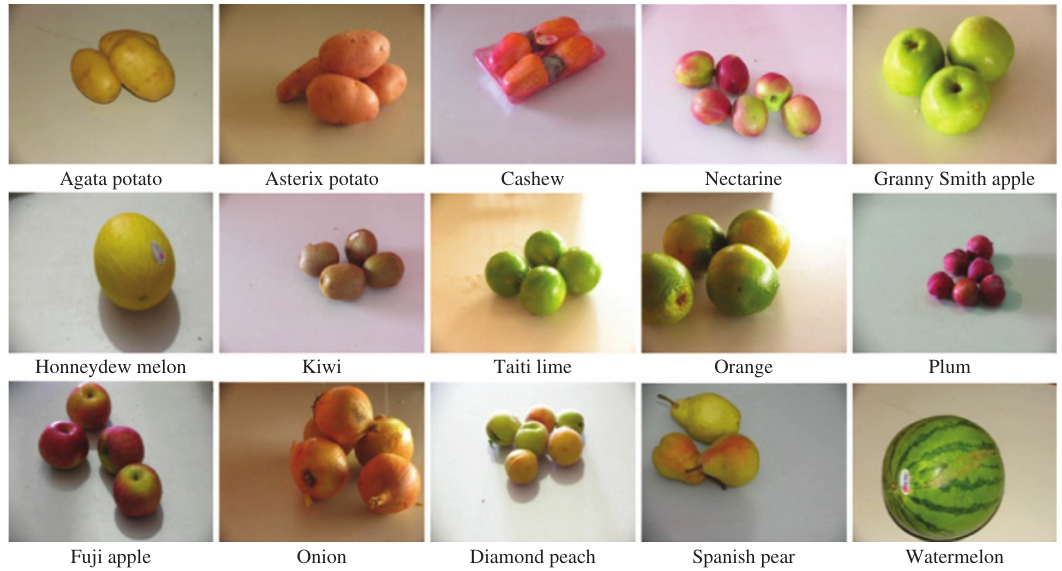
Figure 4. Data Set used in the Fruit and Vegetable Classification Problem